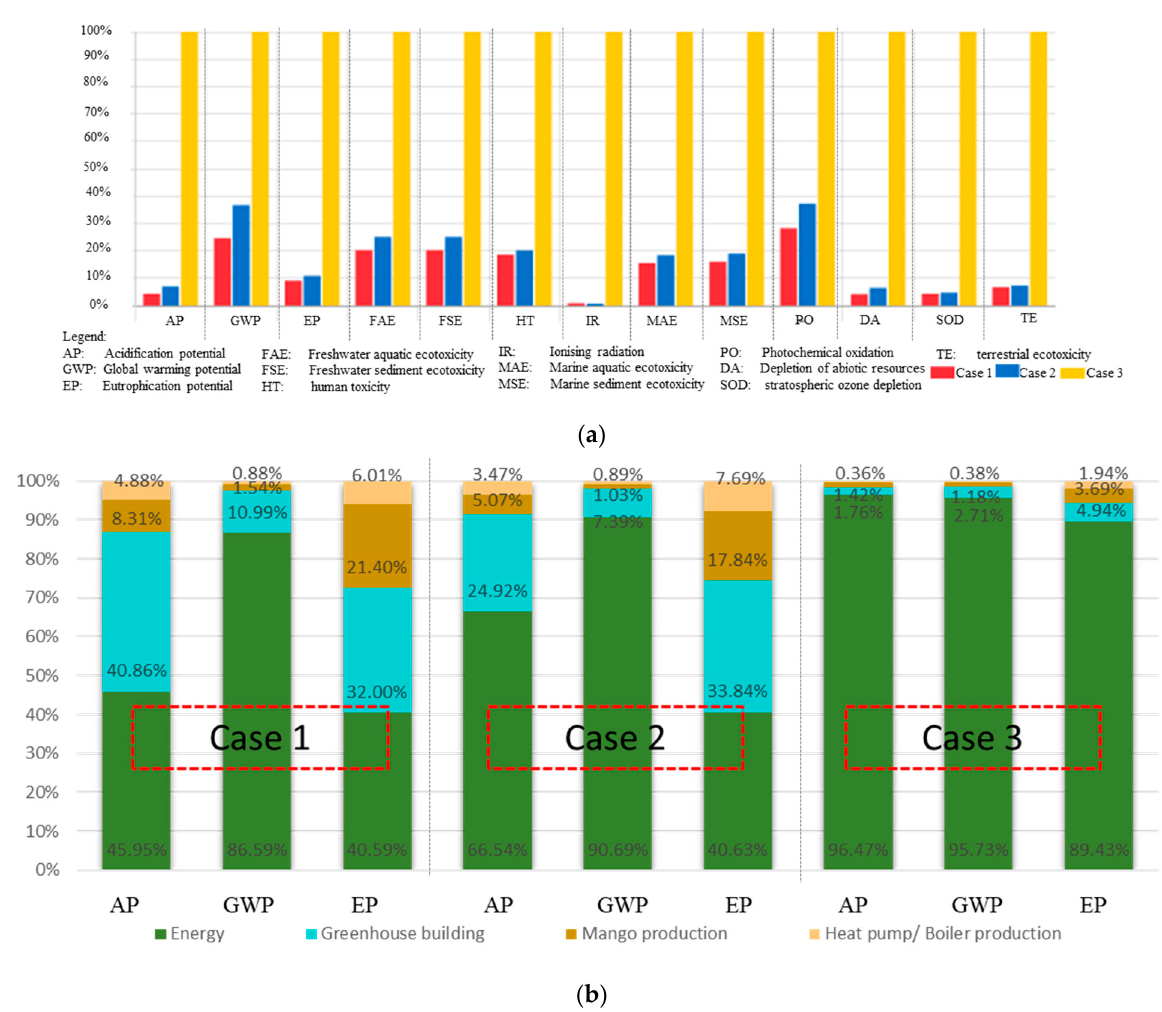
Figure 5. ( a ) Detailed LCIA result and ( b ) distribution of environmental category based on system components.